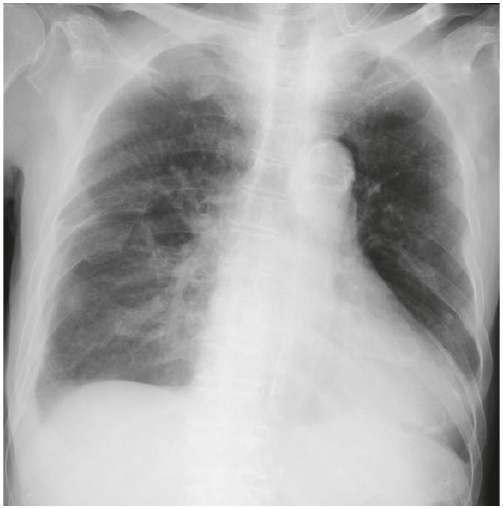
Figure 1: Chest radiography on admission revealed mild widening of cardiac silhouette and right pleural effusion.